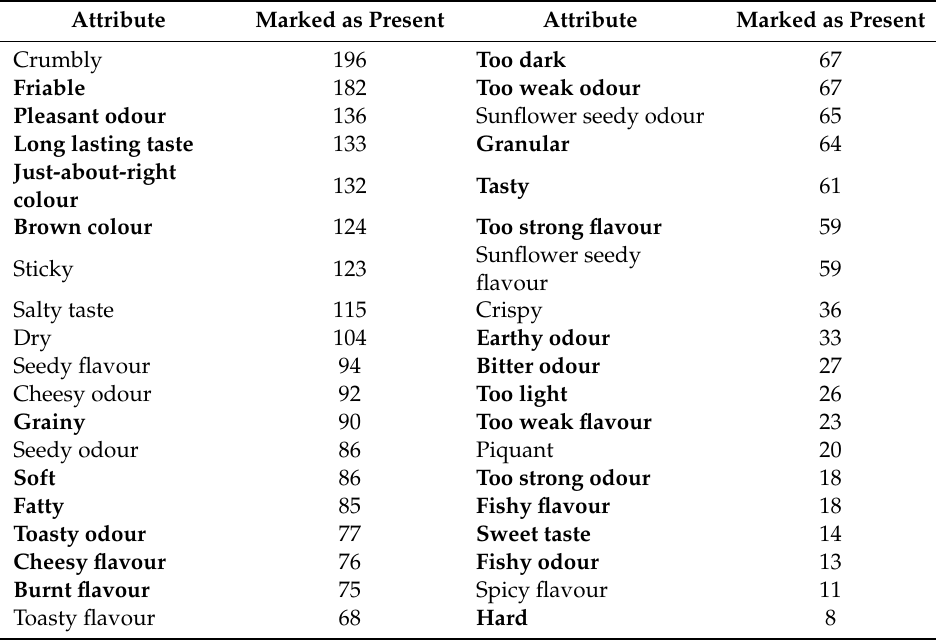
Table 7. Frequency of marking of the CATA terms for all four biscuit